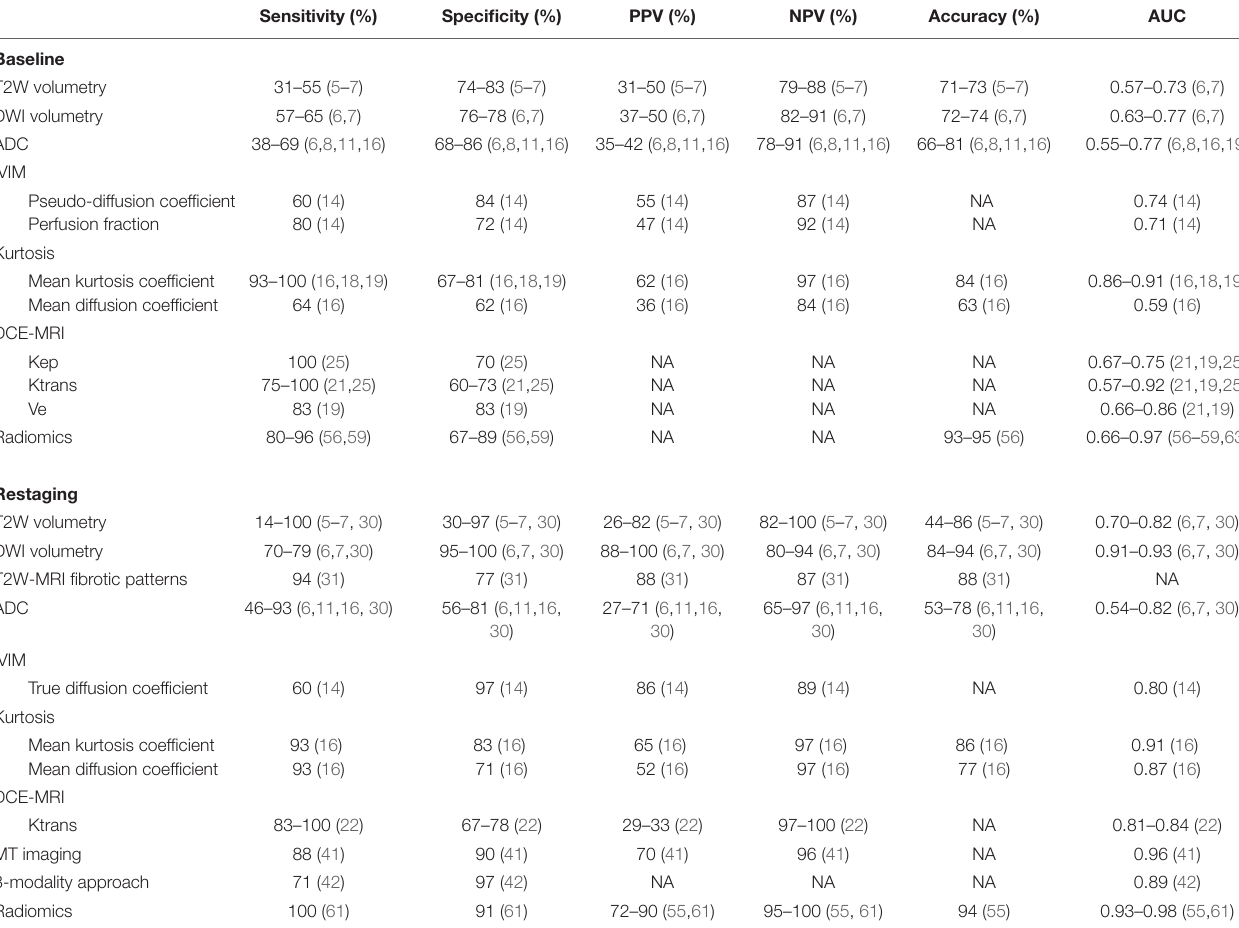
TABLE 1 | Overview of the accuracy and predictive values of the different MRI techniques during baseline and restaging to identify pathological complete response. Sensitivity (%) Specificity (%) PPV (%) NPV (%) Accuracy